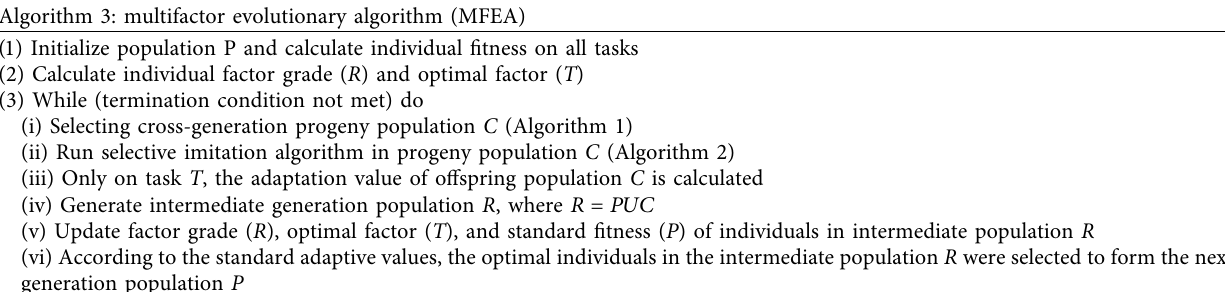
Table 3: Pseudocode of multifactor evolutionary algorithm. Algorithm 3: multifactor evolutionary algorithm